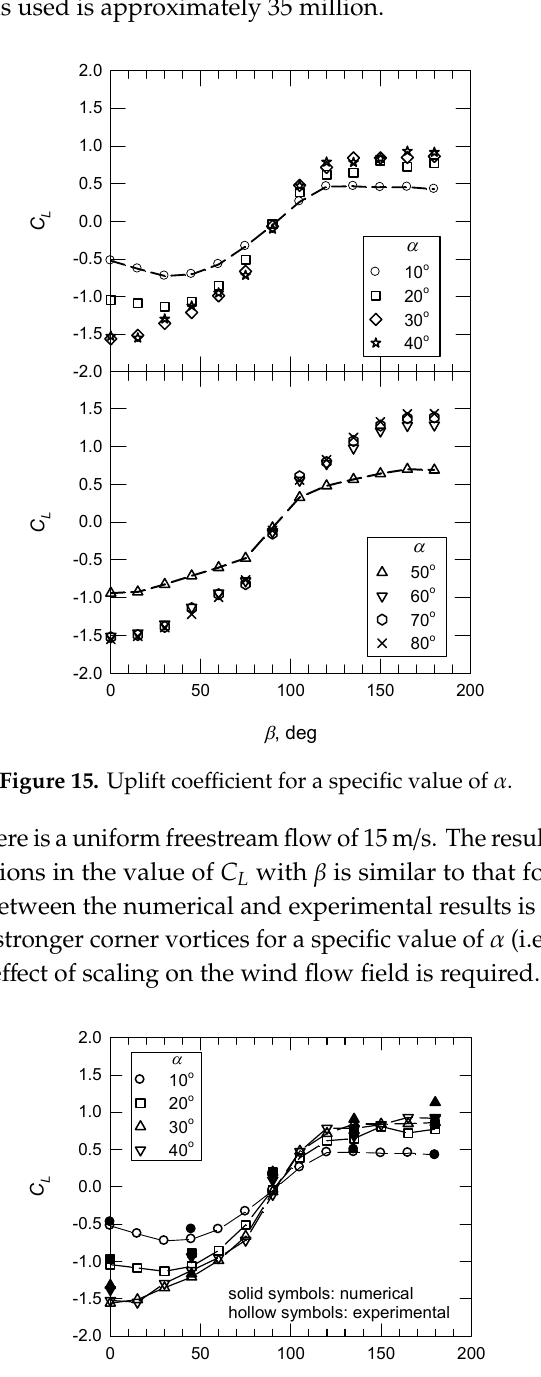
Figure 14. The effect of β on dC L /dα.